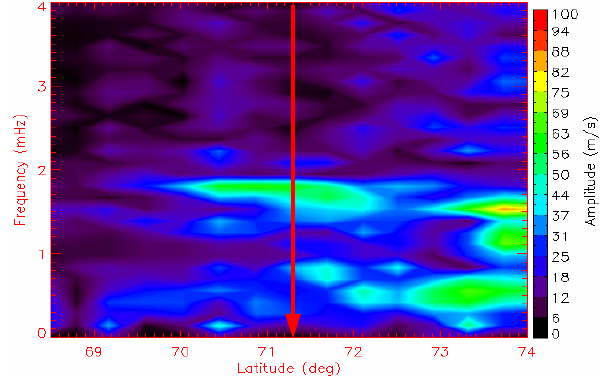
Fig. 1 . The summary plot of line-of-sight Doppler velocity collected from beam 2 of the Goose Fig. 1. The summary plot of line-of-sight Doppler velocity col- on the 11 November 2002 lected from beam 2 of the Goose on the 11 November 2002.